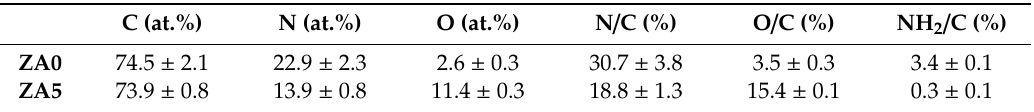
Table 2. Elemental composition of plasma-polymerized allylamine (PPAAm)-coated zirconia surfaces (ZA0) and aged surfaces (ZA5) determined with